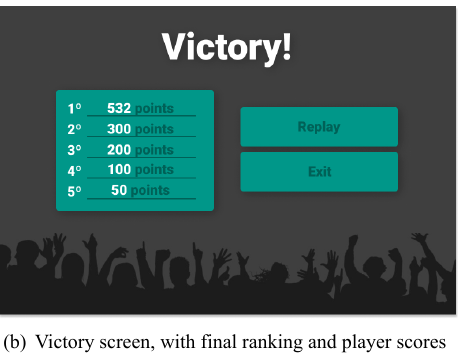
Figure 8. Game over and victory screens